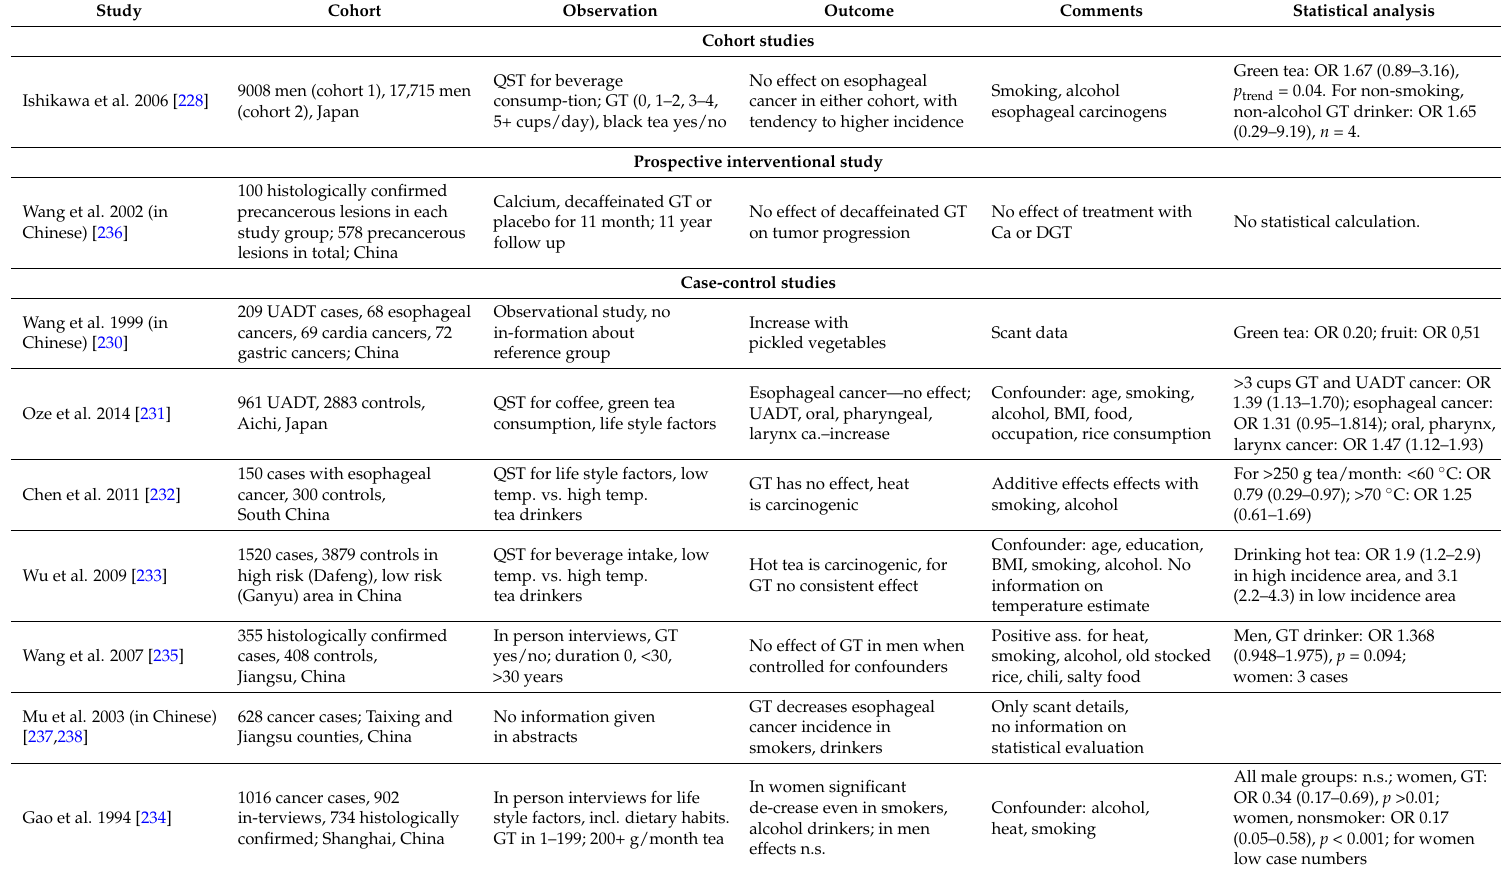
Table 8. Correlation of GTE consumption and chemoprevention of esophageal